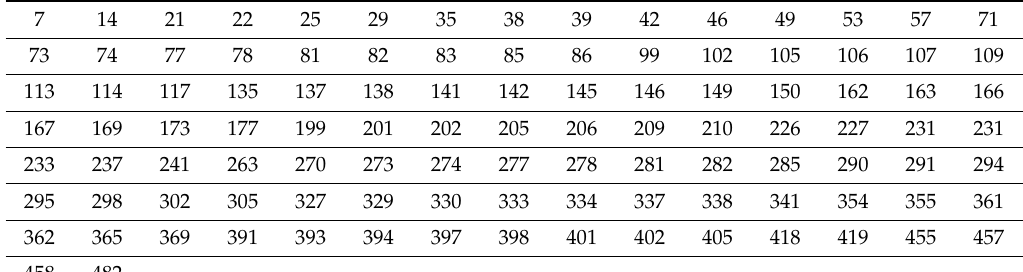
Table 8. x5 corresponding to block R texture template (decimal).